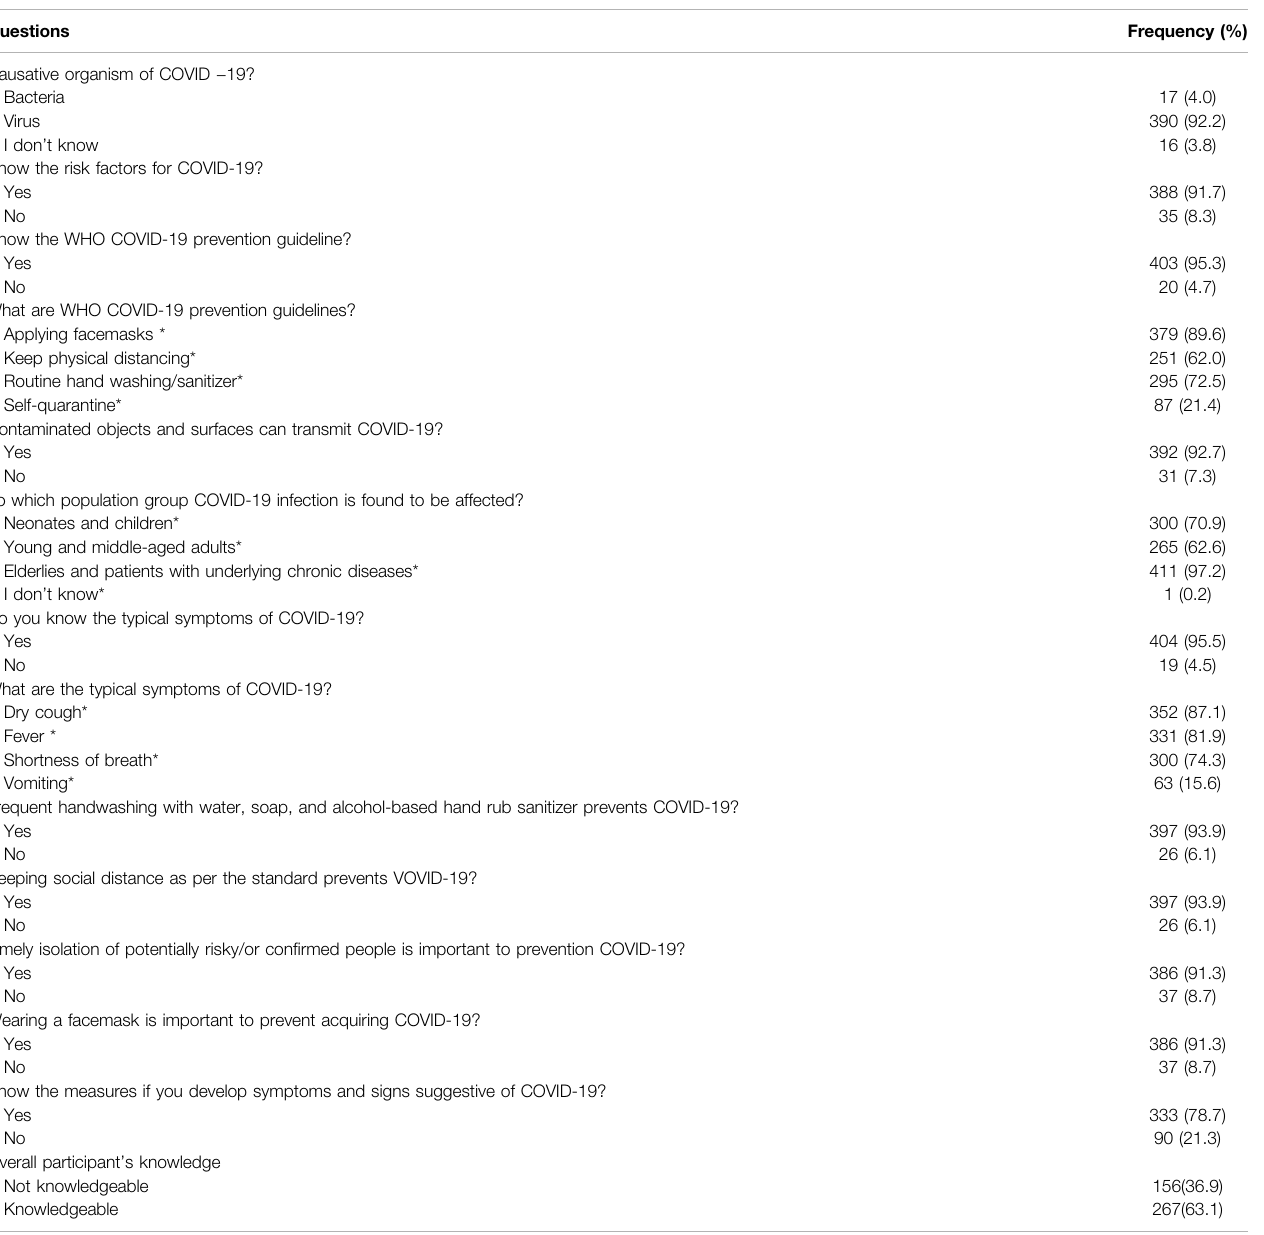
TABLE 2 | Participants ’ knowledge related characteristics about COVID-19 in Debre Berhan University, Northeast Ethiopia, 2021 ( n (cid:1)